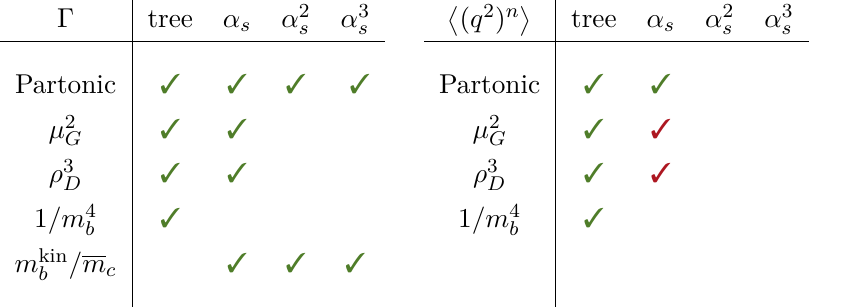
Table 1 . Schematic overview of the perturbative corrections available for the partial rate Γ and the q 2 moments. Green checkmarks denote corrections that are known and built into our code. Red checkmarks indicate corrections that are known, but currently not included in our package. For references and further information we refer to the